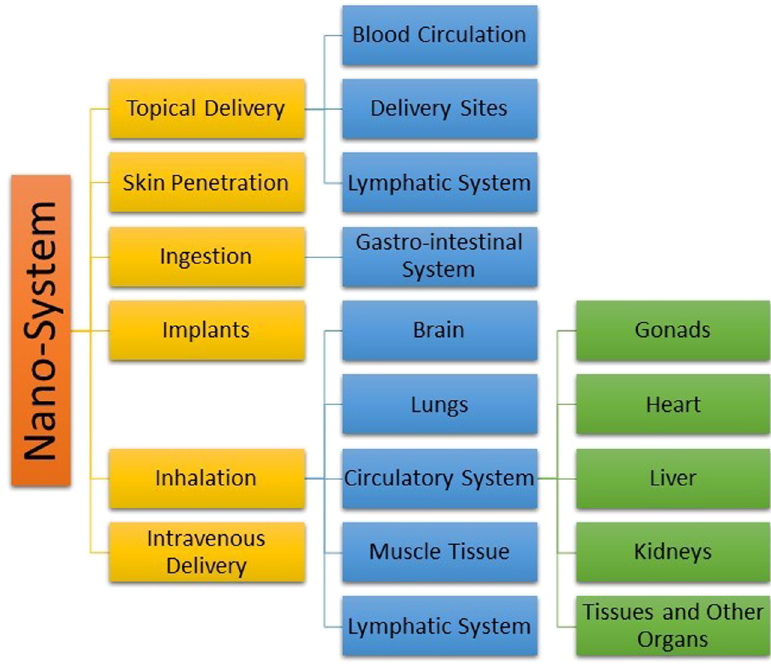
Figure 14: Nanosystem exposure routes and uptake